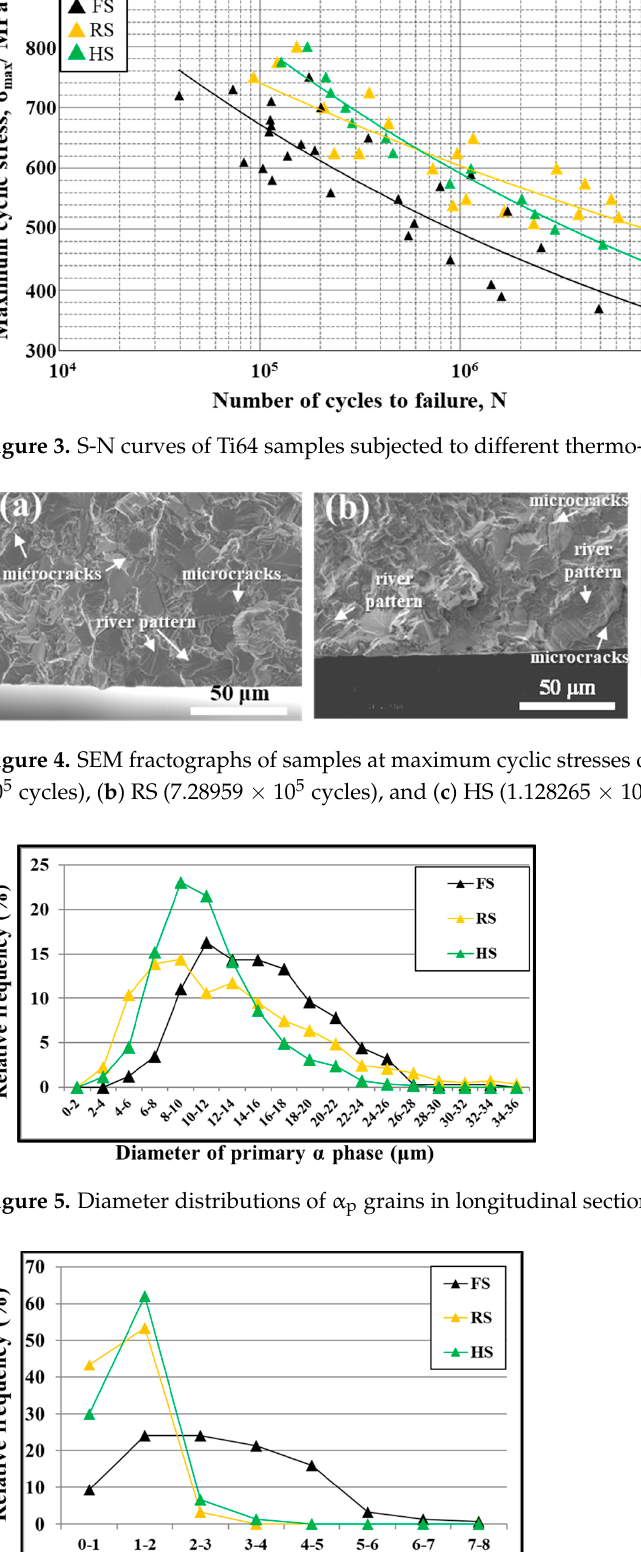
Figure 5. Diameter distributions of α p grains in longitudinal sections obtained from FS, RS, and HS.